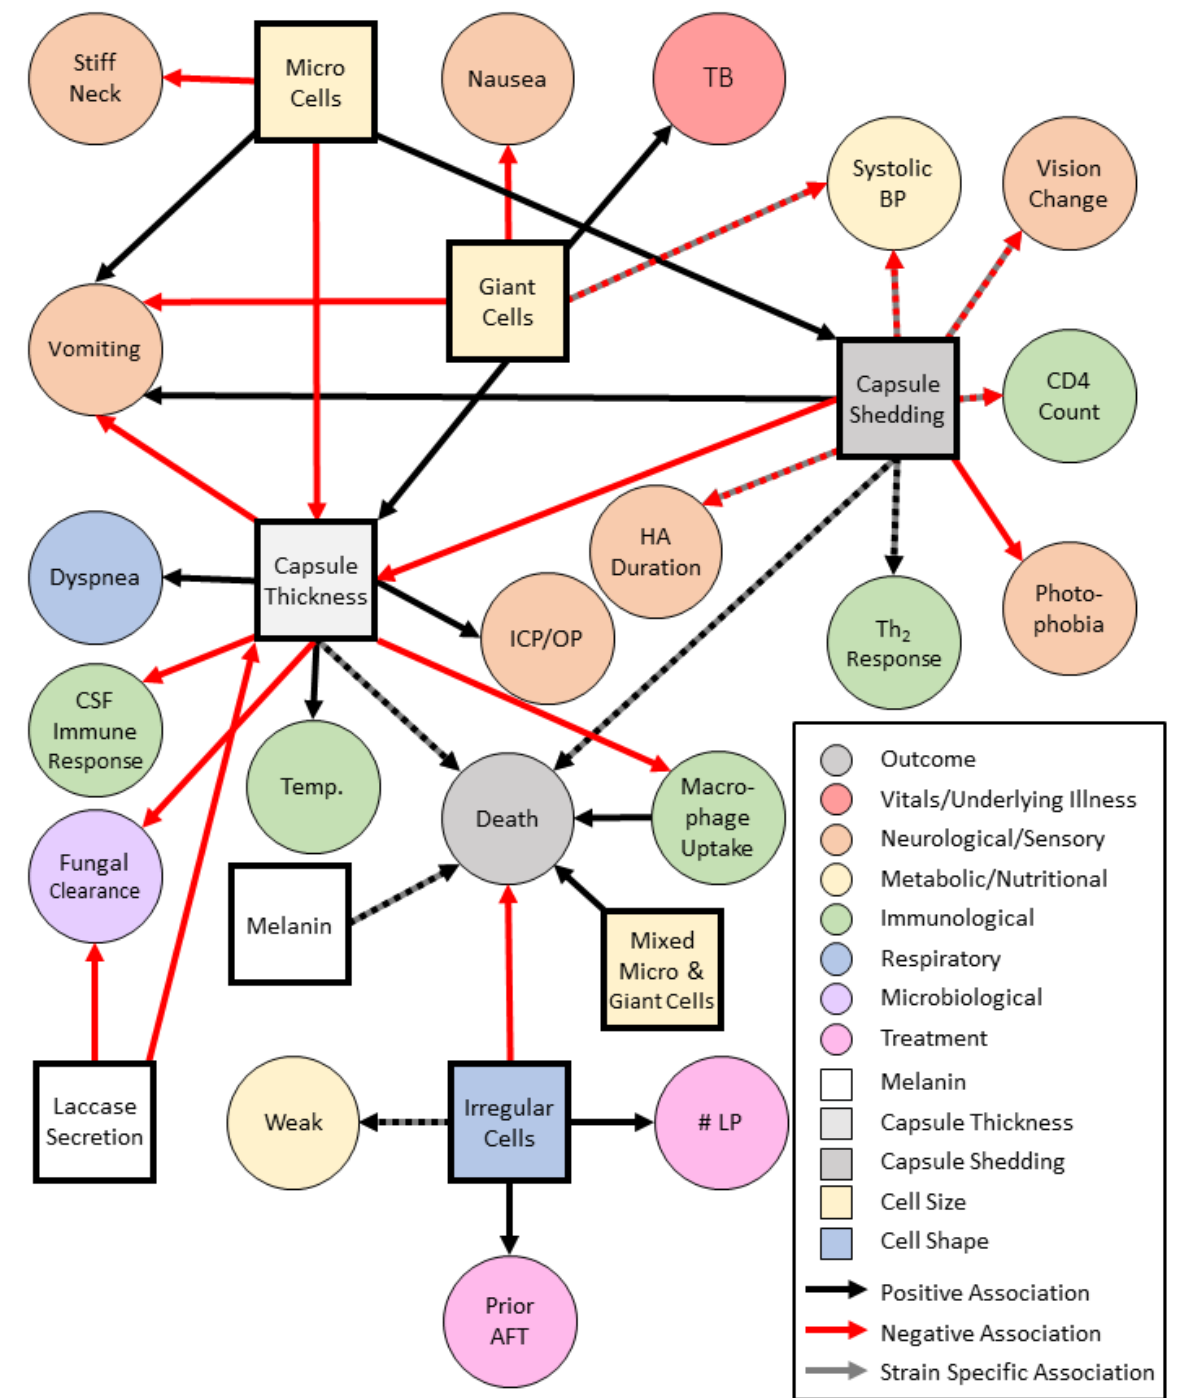
Figure 3. Cryptococcal Phenotype Associations with Human Clinical Presentation. Abbreviations: Tuberculosis (TB), Blood Pressure (BP), Headache (HA), Temperature (Temp.), Lumbar Puncture (LP), Cerebral Spinal Fluid (CSF), Intracranial Pressure/Opening Pressure (ICP/OP), Antifungal Therapy (AFT).